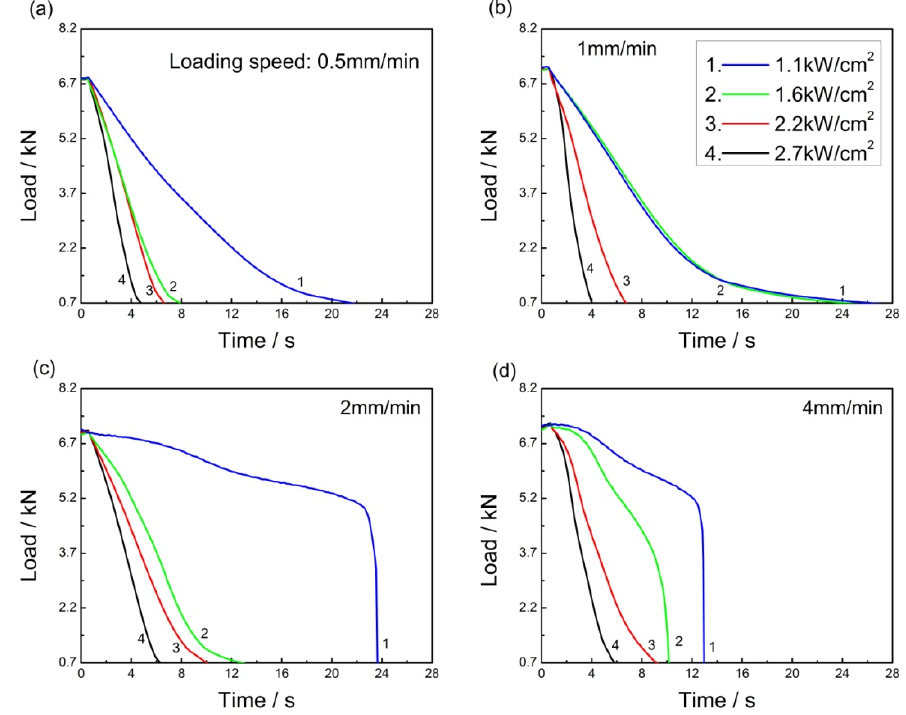
Figure 1. Failure behavior of Al-6061 specimens for various laser power densities under the fixed preloading speeds. ( a ) 0.5 mm/min; ( b ) 1 mm/min; ( c ) 2 mm/min; ( d ) 4 mm/min.